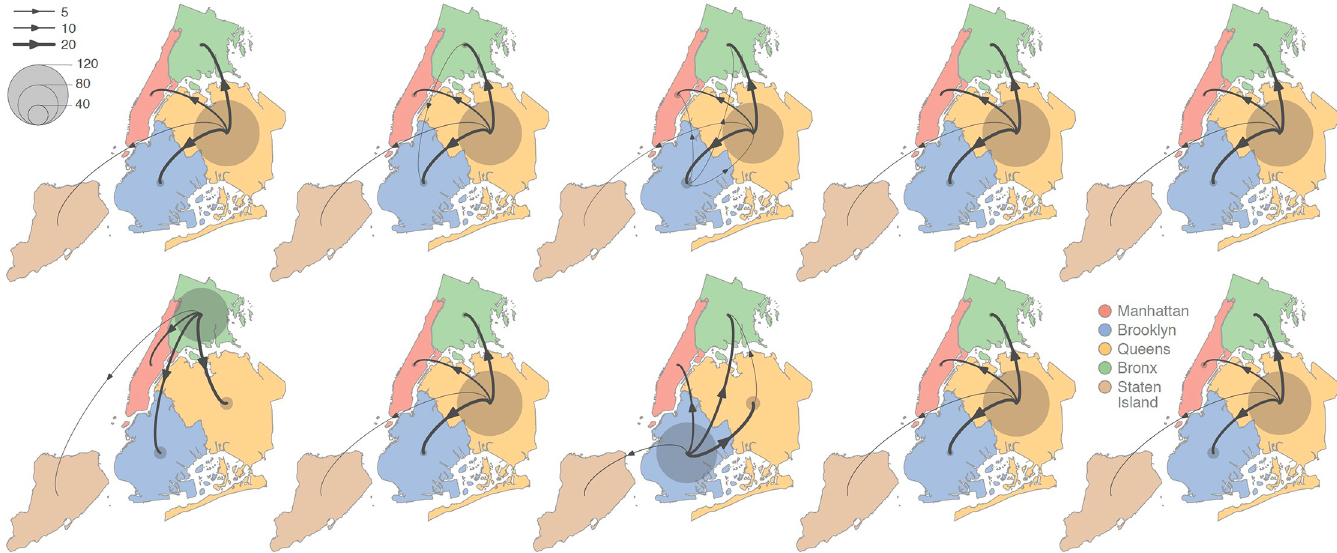
Fig 3. Schematic overview of the discrete phylogeographic analyses of the main SARS-CoV-2 clade circulating in New York City (NYC) during the first epidemic wave. These maps schematize the outcome of each replicated discrete phylogeographic inference based on a random subset of genomic sequences (see the Methods section for further detail). We here report the number of lineage dispersal events inferred among (arrows) and within (transparent grey circles) NYC boroughs, both measures being averaged over 1,000 posterior trees sampled from each posterior distribution. See also S4 Fig for the estimated Markov jumps among NYC boroughs, an alternative yet congruent representation of the lineage transition events inferred by discrete phylogeographic analyses. Base layer for the maps has been obtained from https://www.census.gov.